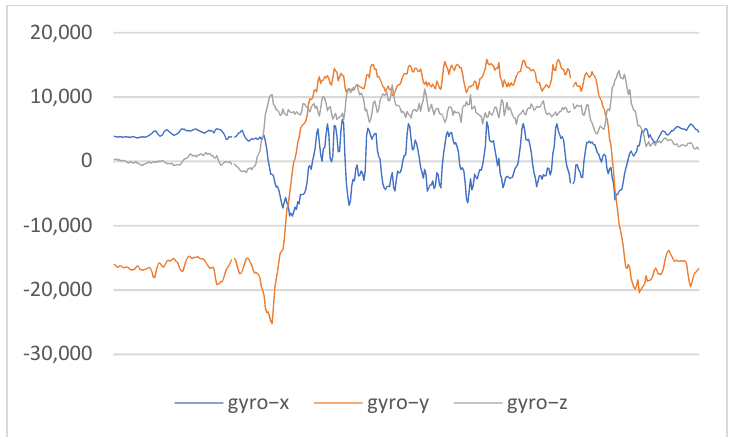
Figure 7 . Eye rubbing gyroscope data . Figure 7. Eye rubbing gyroscope